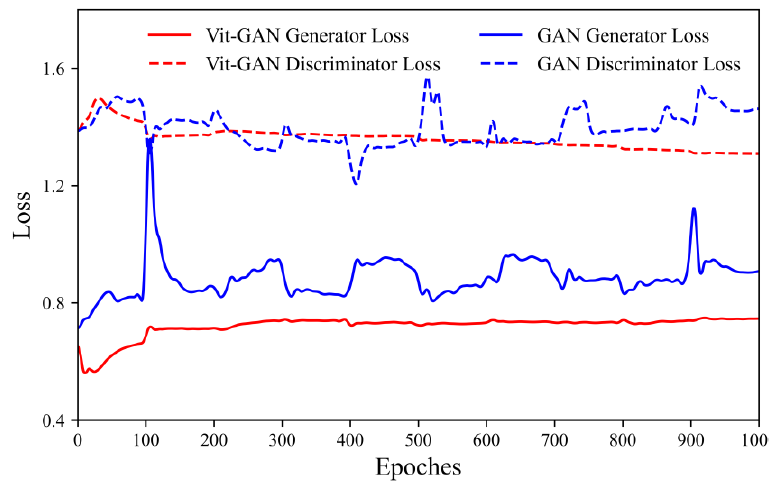
Figure 16. Loss function curves of GAN algorithm and Vit-GAN algorithm.